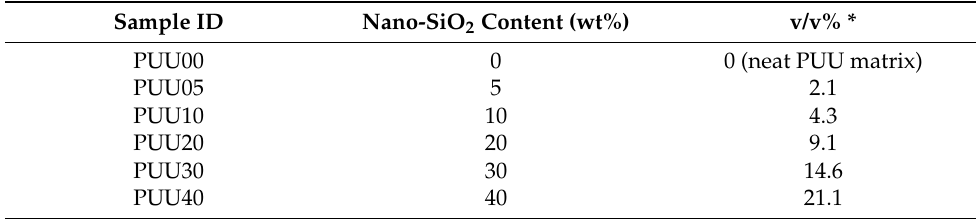
Table 1. List of studied PUU/SiO 2 nanocomposites (PUU =